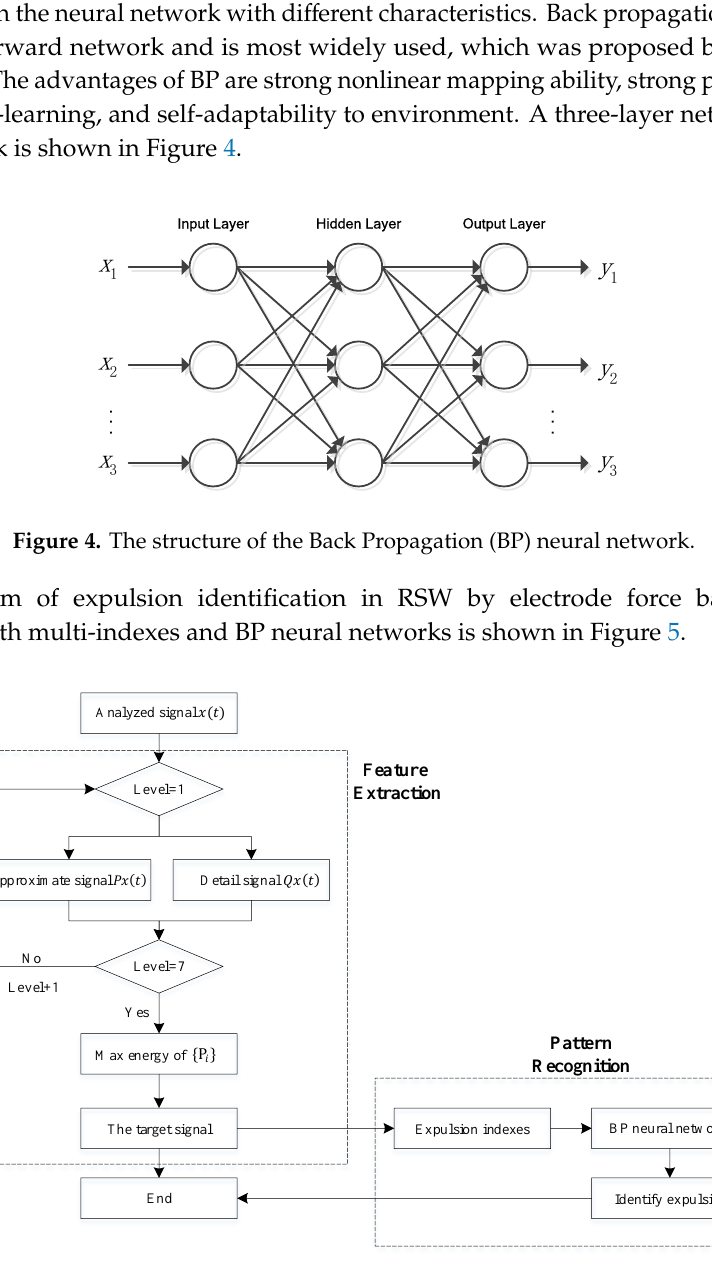
Figure 5. The flow chart of the algorithm.